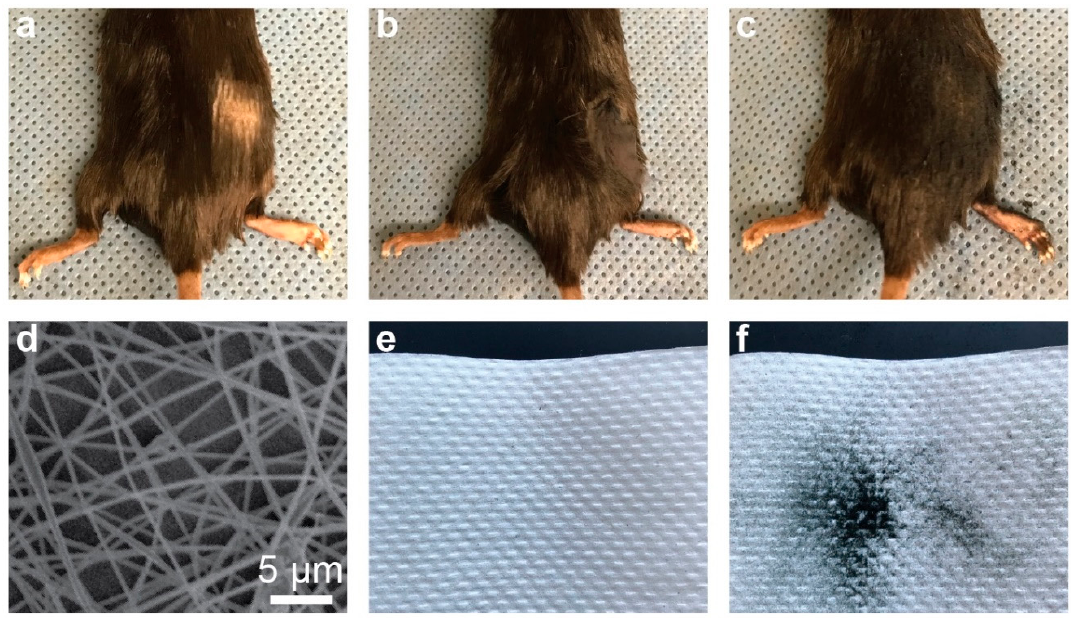
Figure 5. Application of the portable electrospinner for hair thickening. ( a ) A black-haired mouse with a small patch of hair removed. ( b ) Hair-thickening with black-dyed, electrospun PAN nanofibers. ( c ) Hair-thickening with a commercial powder product (Toppik ™ ). ( d ) SEM image of the dyed PAN nanofibers. ( e ) Virtually no residue is left after contacting the nanofiber-treated skin to a napkin. ( f ) Significant residue left after contacting the Toppik ™ -treated skin to a napkin.